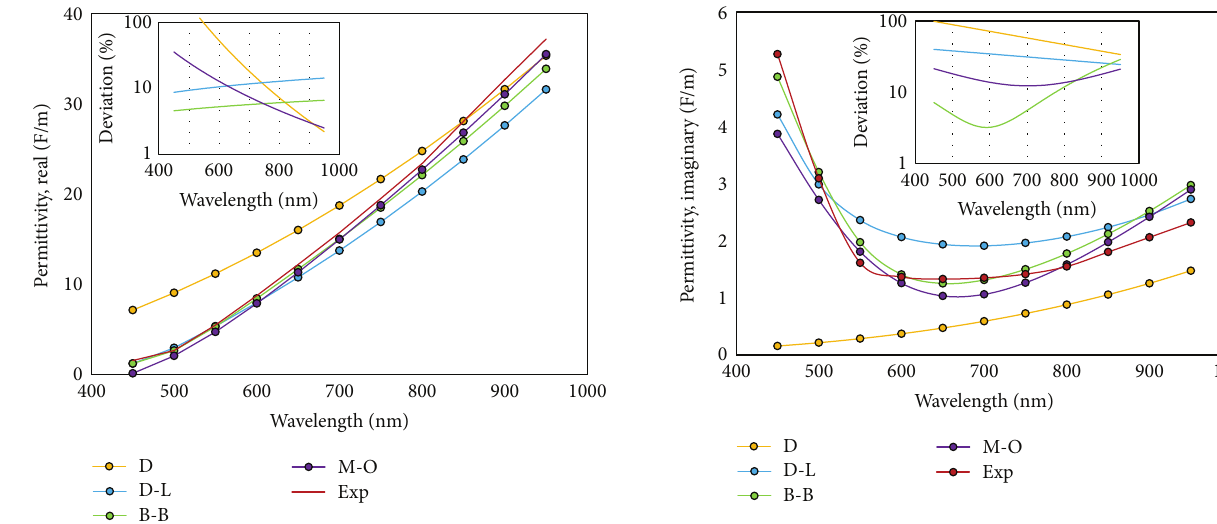
Figure 2: Imaginary part of permittivity (F/m) against wavelength (nm) for all four models compared to experimental data. Inset: error value of the permittivity against wavelength indicating the accuracy of the B-B model with less than 10% deviation.